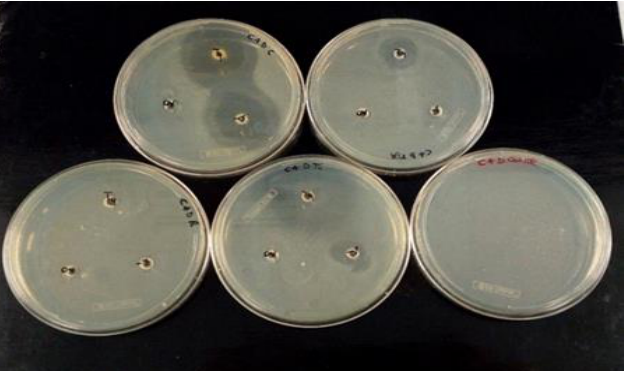
Figure 5. Comparison between a total of eight samples from water pools and stone drinking troughs, separately analyzed, in triplicate. Results are expressed as the mean ± SD.